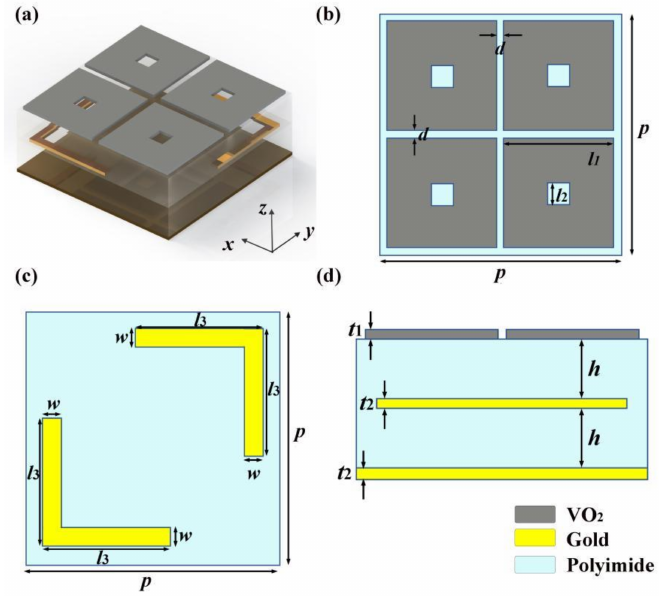
Figure 1. ( a ) The schematic diagram of the periodic cell structure of the metamaterial. ( b ) A top view of the VO 2 square-ring structure within the cell structure. ( c ) A top view of the gold aperture square-ring structure within the cell structure. ( d ) A side view of the cell